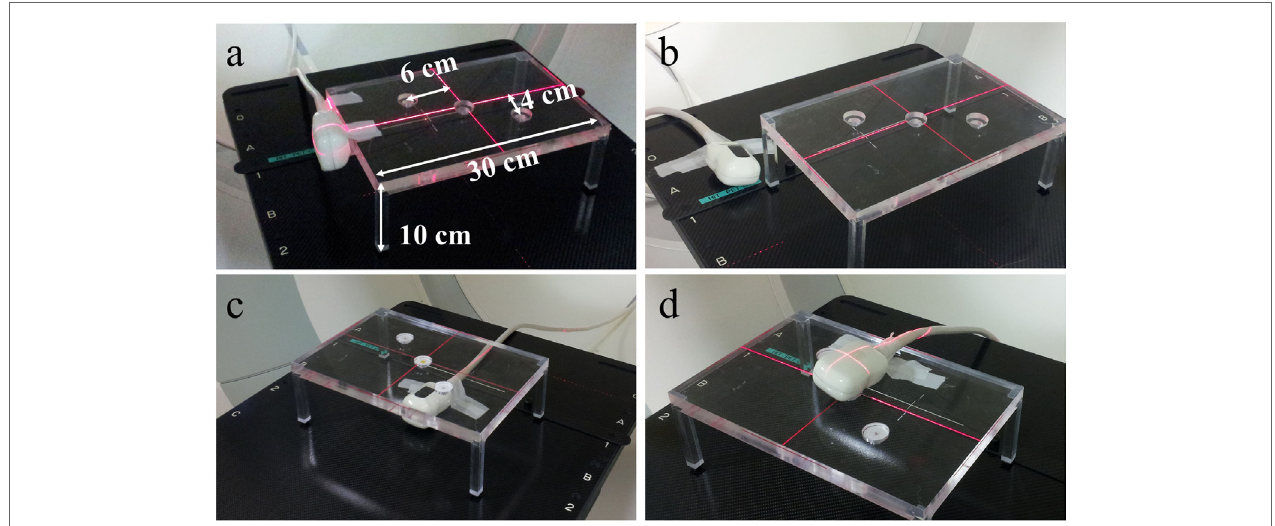
FigUre 4 | experimental setup for investigation of the Us transducer’s influence on PeT image reconstruction . The three radioactive point sources were aligned in a horizontal diagonal line within the acrylic glass table. The measurement was repeated with the transducer in four different positions: (a) next to table (edge), (B) next to table (corner), (c) under table, and (D) on